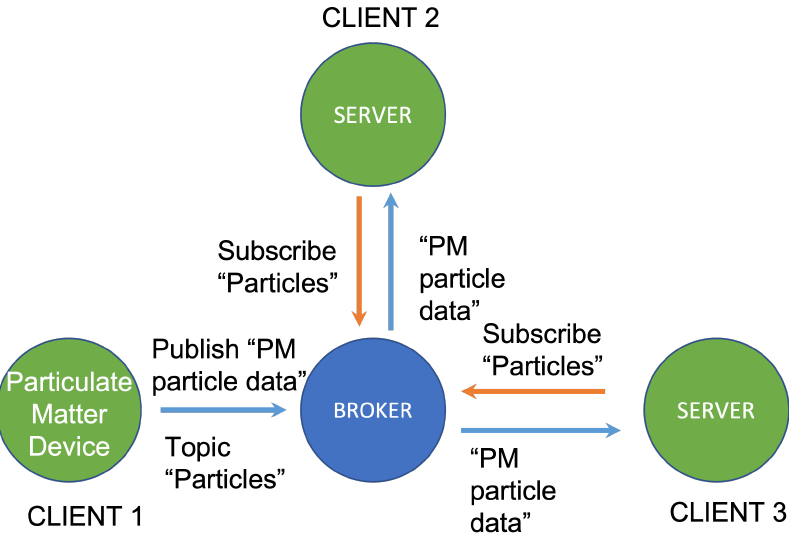
Figure 3. Diagram of the particulate matter device